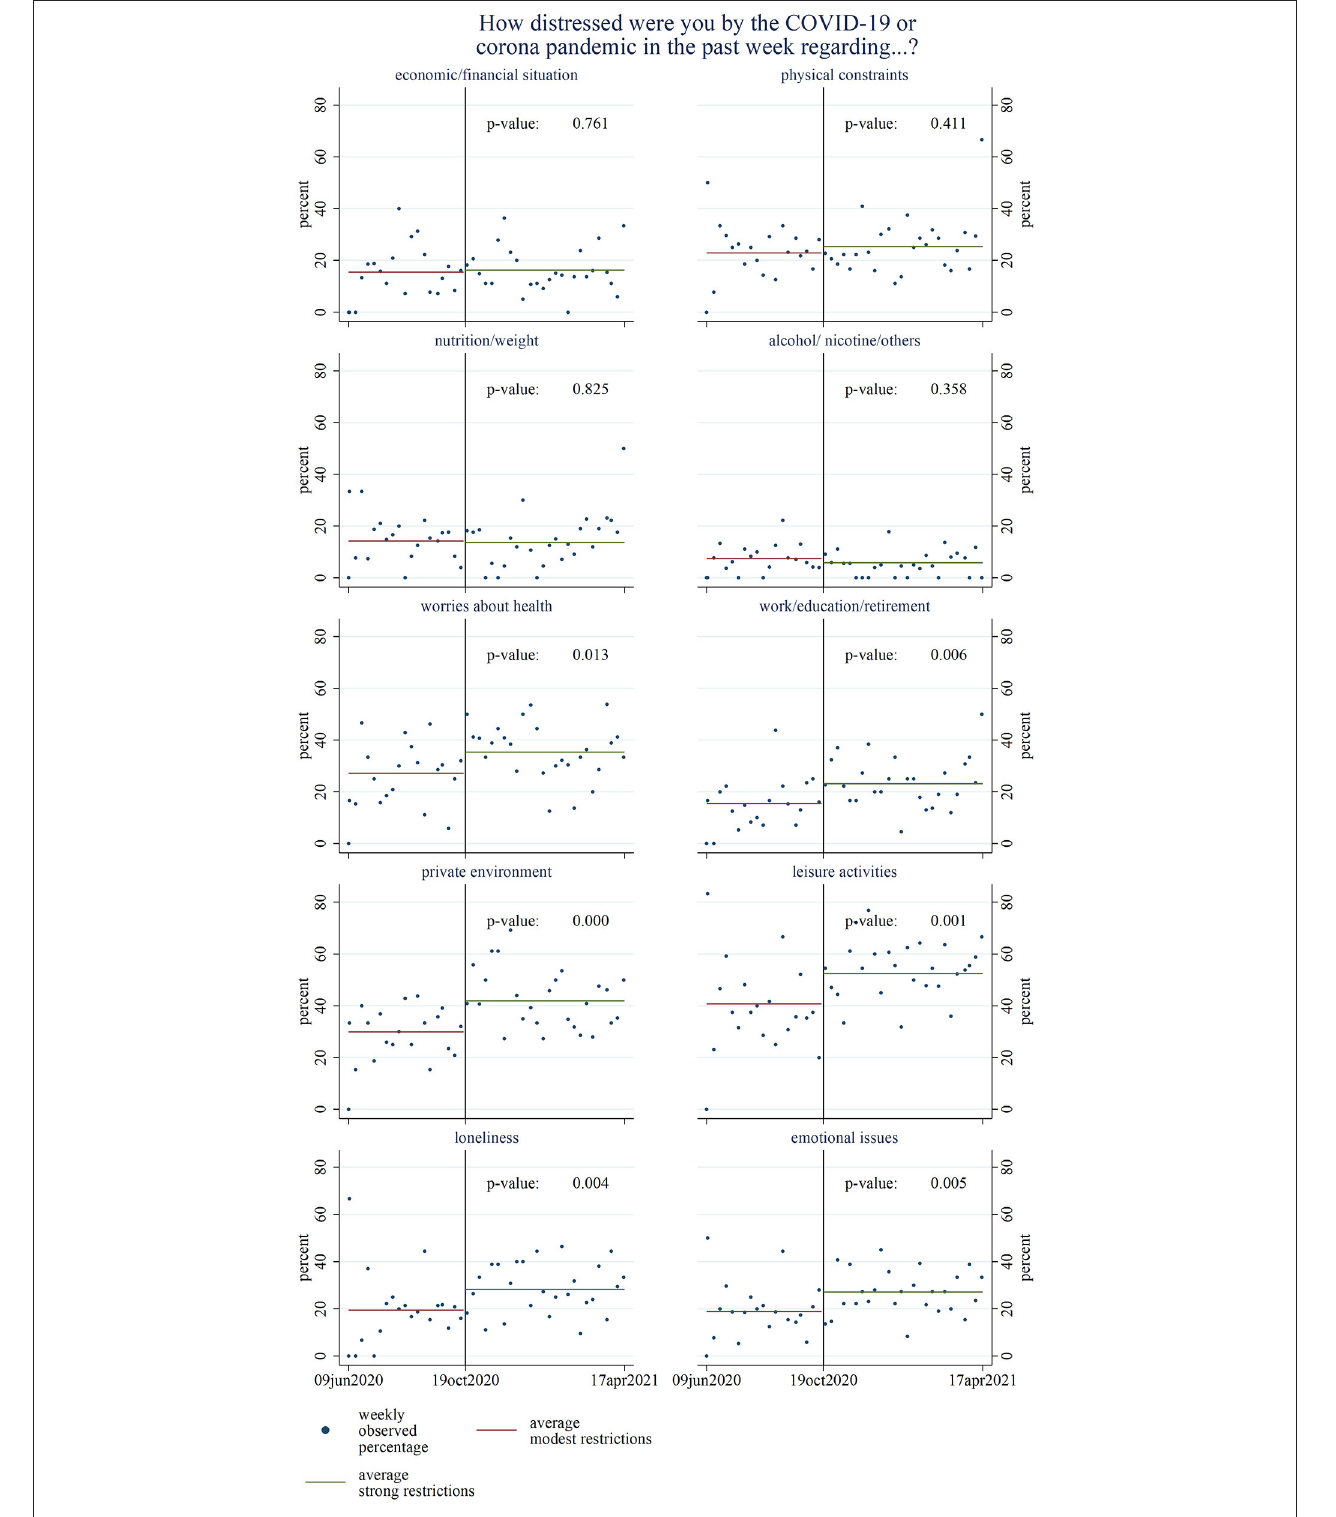
FIGURE 2 | Comparison of weekly percentage of hospital inpatients stating being slightly or substantially more distressed due to the coronavirus disease 2019 (COVID-19) pandemic in the respective life area between the pre-period of modest and post-period of strong COVID-19 restrictions ( N = 873). P -values are based on unadjusted linear regression